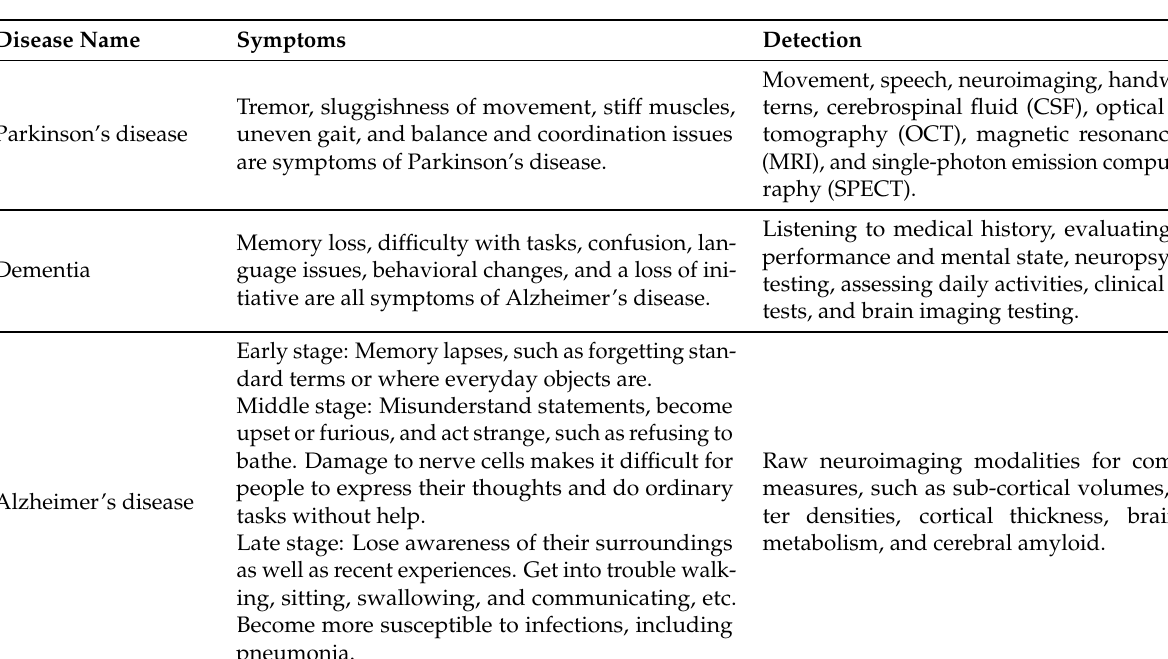
Table 7. This is a dataset for symptoms and detection modalities for different neurological